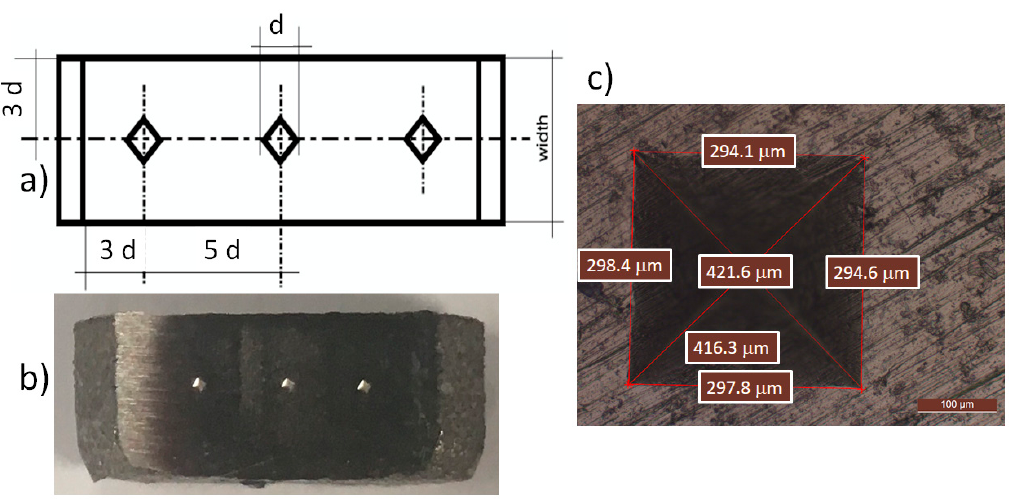
Figure 13. Macro-instrumented indentation test (MIIT) at the center: ( a ) separation distance between indents; ( b ) actual Vickers indentations; ( c ) typical Vickers macro-imprint in the b-sample.